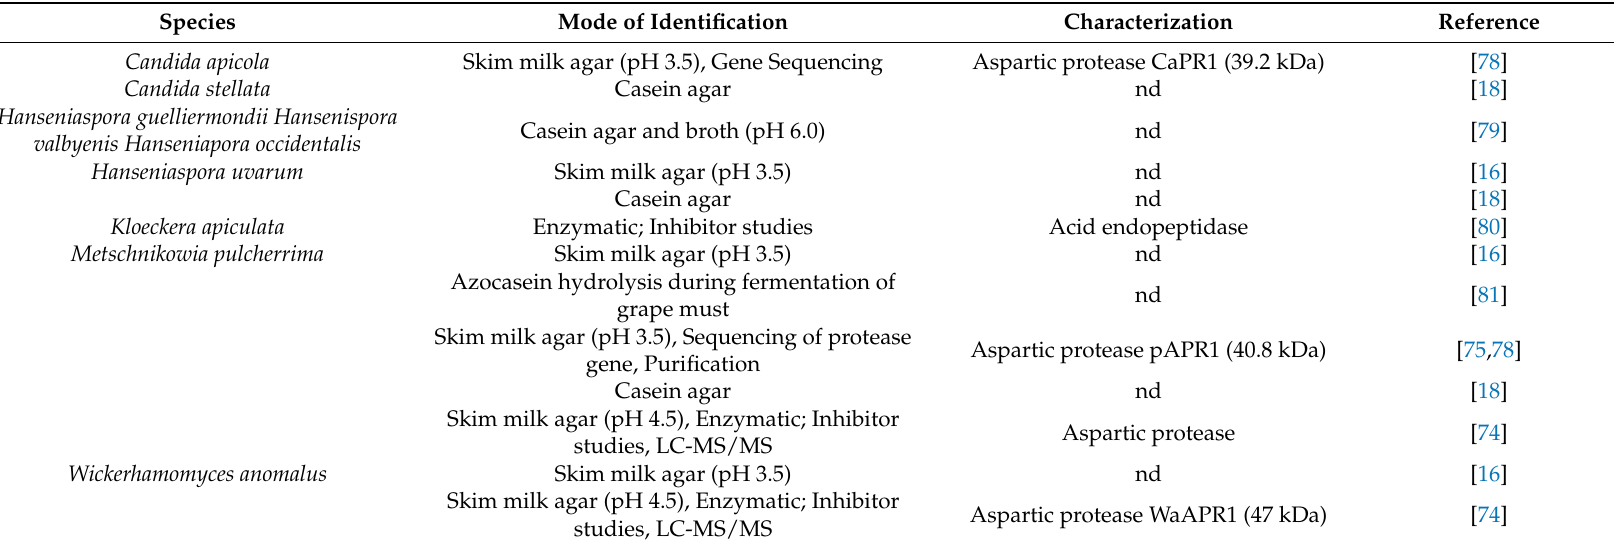
Table 6. Extracellular proteases of non- Saccharomyces yeasts with possible use for wine